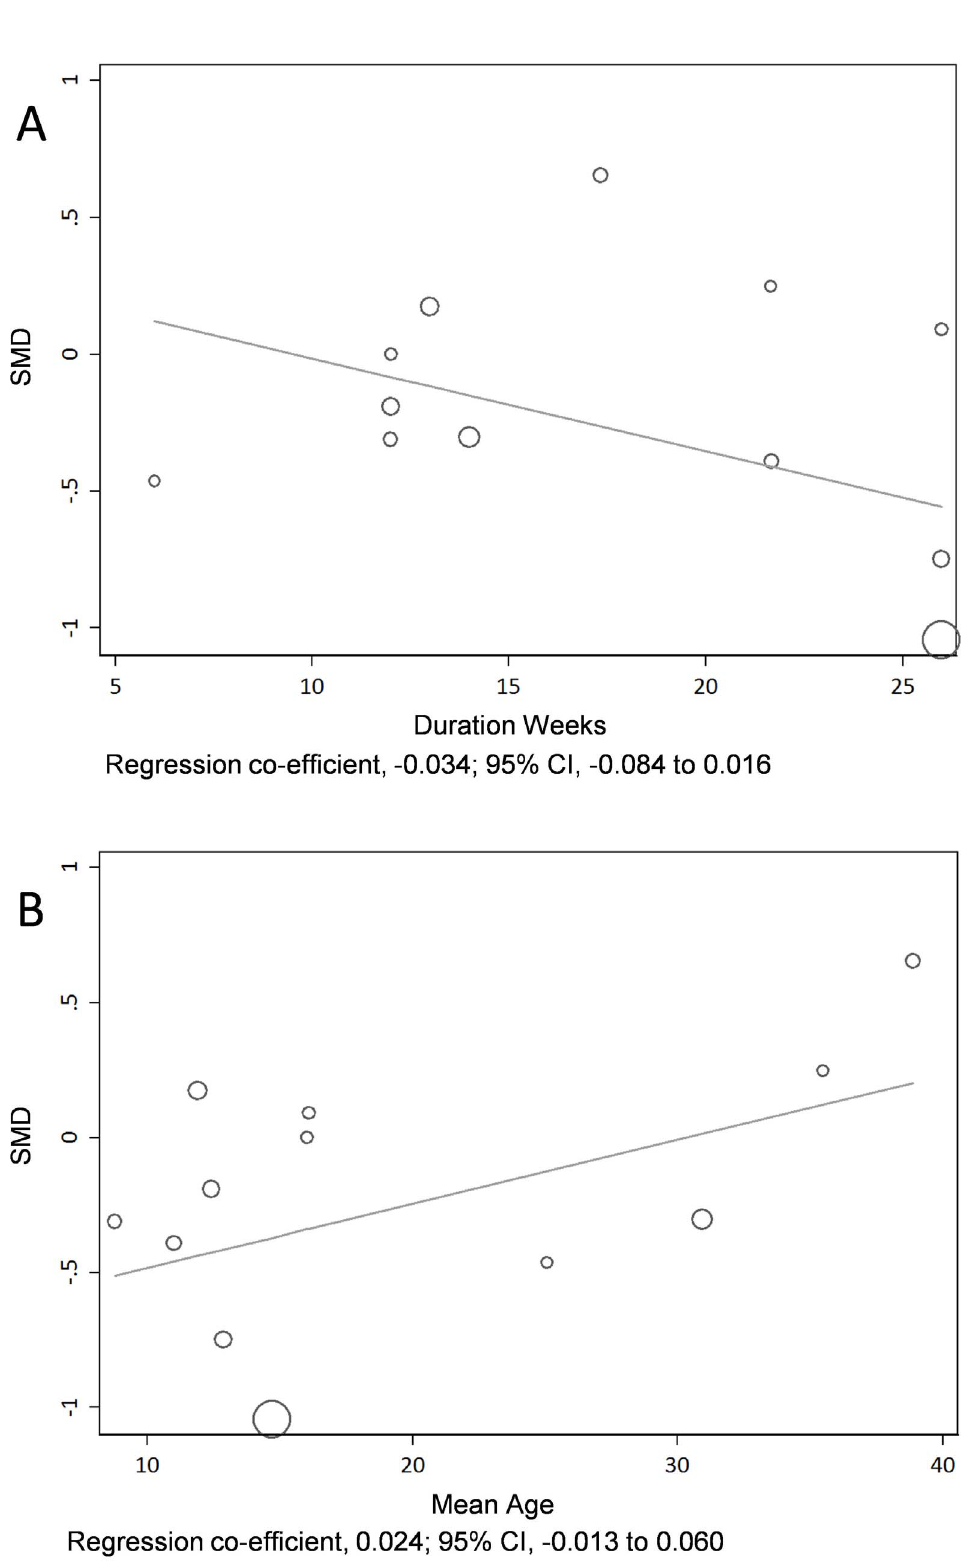
Figure 3. Metaregression by duration of study (A) and age of participants (B).